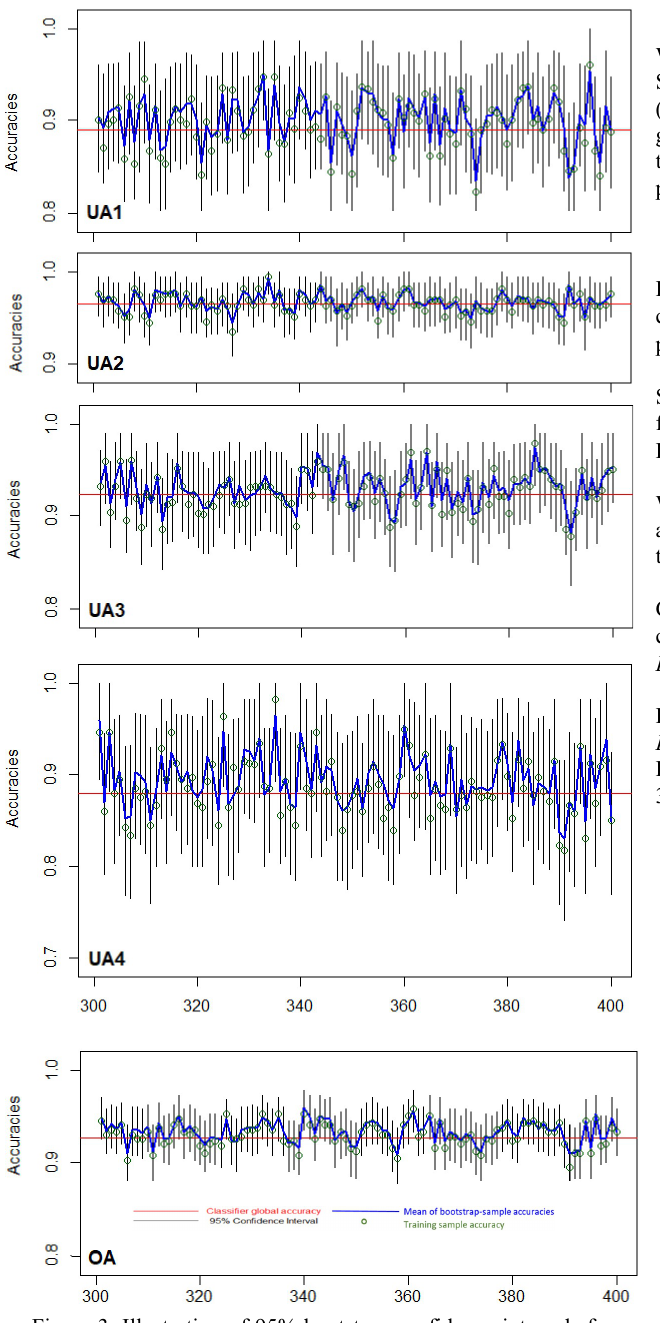
Figure 3. Illustration of 95% bootstrap confidence intervals for the 4-class, 3-feature